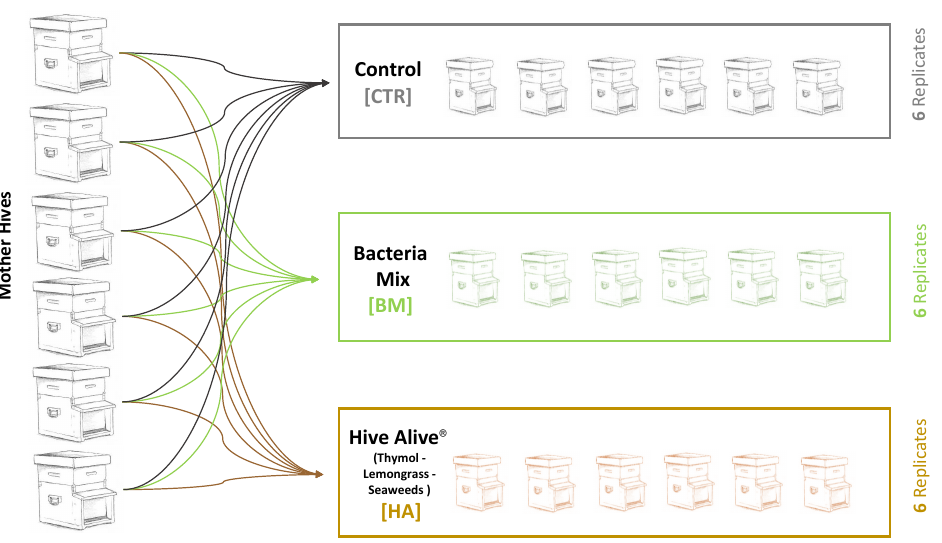
Figure 1. Experimental Design. Schematic representation of the field trial. The figure reports the scheme of the tests and the number of bees and beehives used in the